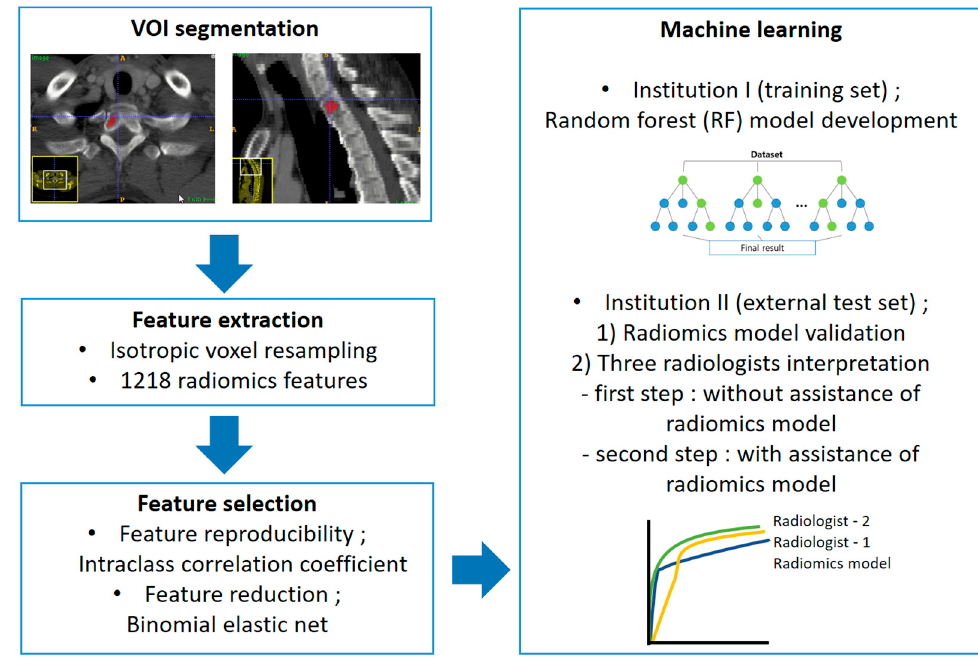
Figure 3. Radiomics pipeline of this